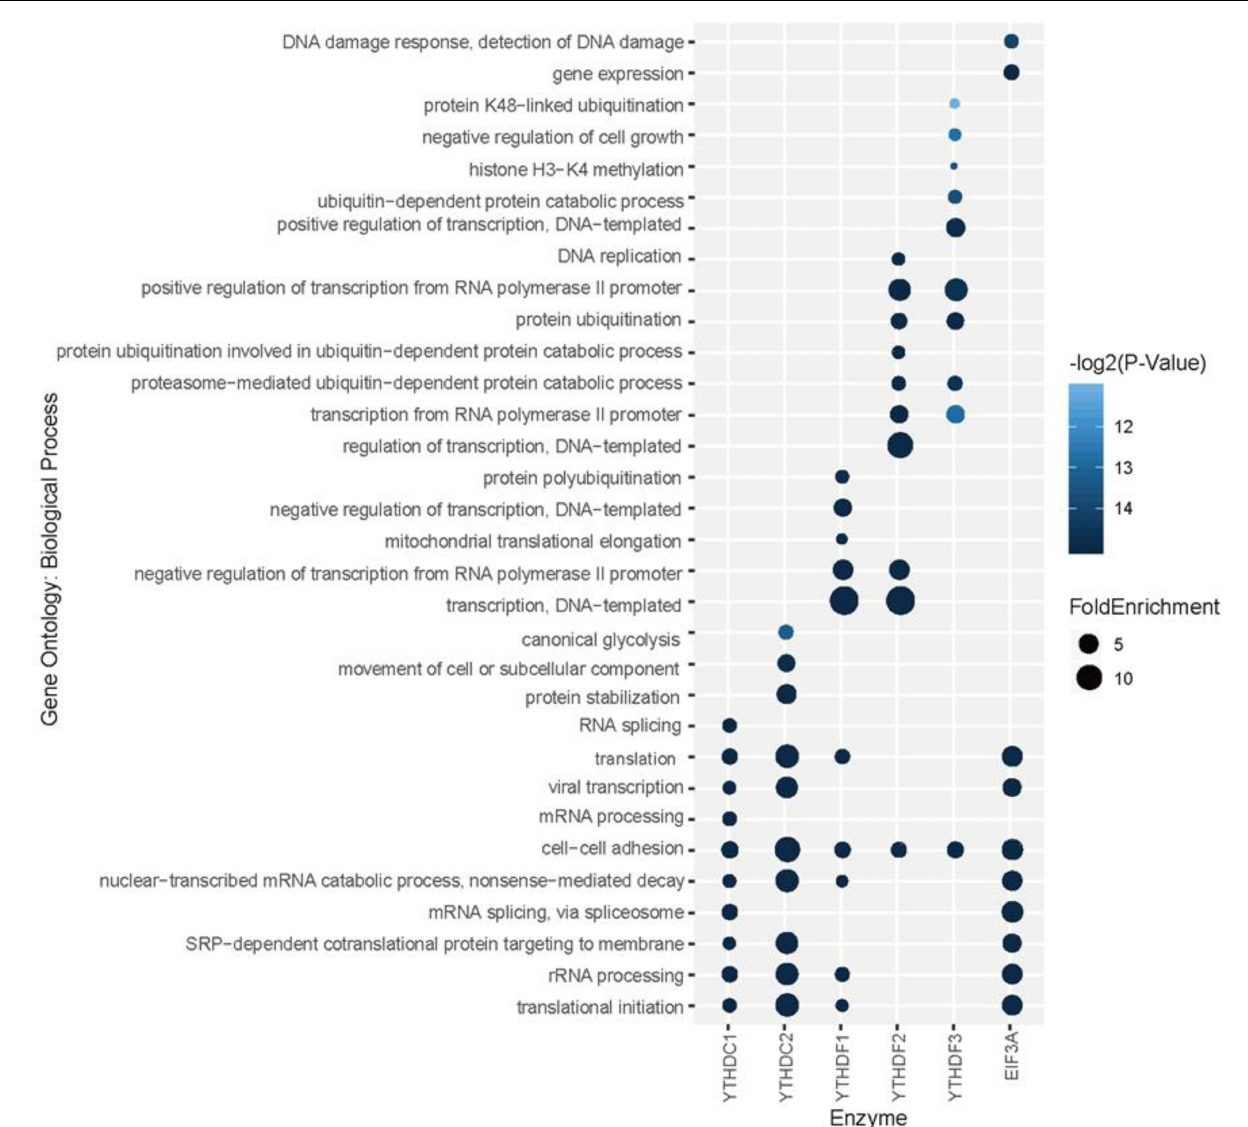
FIGURE 5 | Gene ontology (GO) enrichment analysis for each reader’s substrates. The top 10 GO functions related to each m 6 A readers are presented.